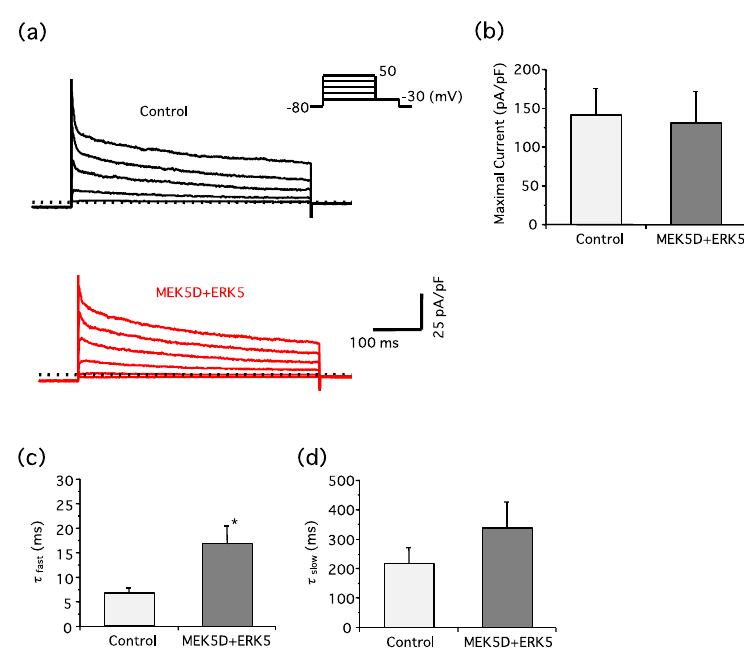
Figure 4. ERK5 inhibits inactivation of the A-type current in PC12 cells. PC12 cells were co-transfected with EGFP, MEK5D, and ERK5. Two days after transfection, the A-type current was recorded. ( a ) Representative traces and step-pulse protocol are shown; ( b ) maximal peak current was measured at +50 mV. The ERK5 did not significantly change amplitude levels (data from three independent experiments ( n = 4), unpaired Student’s t -test); (c,d) the time constant ( τ ) at fast ( c ) and slow ( d ) phases at +50 mV was calculated. ERK5 significantly changed the time constant ( τ ) at the fast phase (data